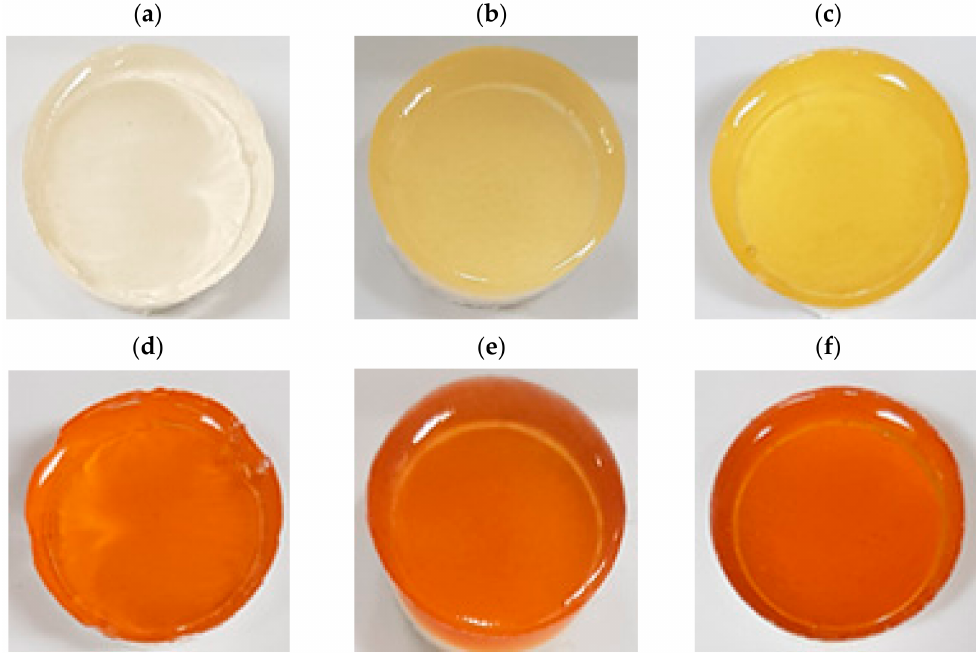
Figure 4. Exterior photos of 6%, 18%, and 30% gelatin gels with or without red maple leaf extract (1000 mg/L). ( a ) 6% gelatin gel; ( b ) 18% gelatin gel; ( c ) 30% gelatin gel; ( d ) 6% gelatin gel with red maple leaf extract; ( e ) 18% gelatin gel with red maple leaf extract; ( f ) 30% gelatin gel with red maple leaf extract. Table 1. Color characteristics of 6%, 18%, and 30% gelatin gels formulated with red maple leaf extracts. 6% Gelatin Traits